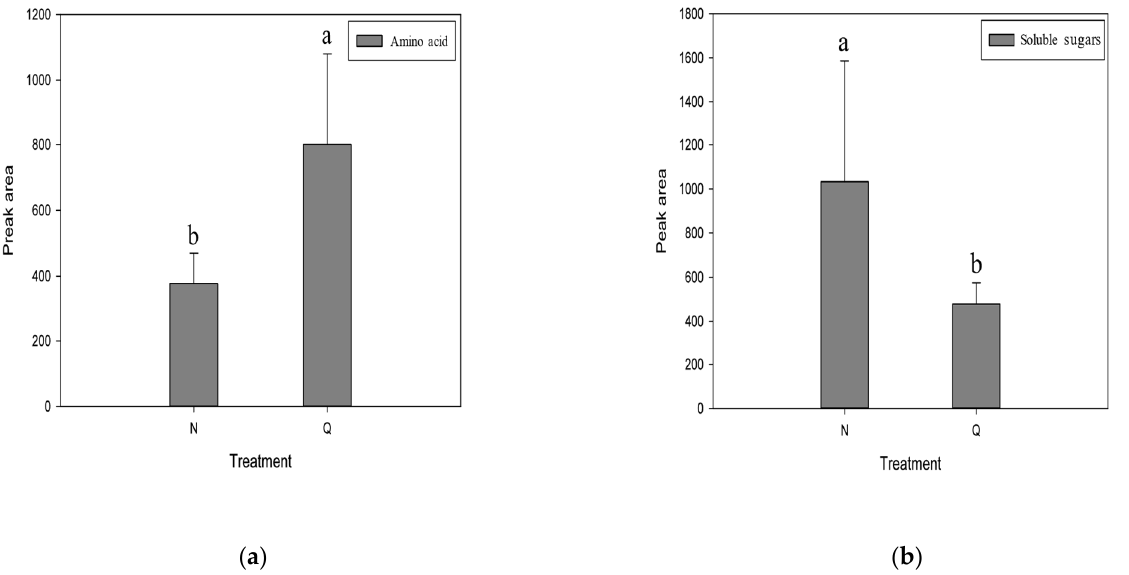
Figure 5. Changes in physiological indicators of R. chrysanthum under UV-B stress in control (N) and UV-B domestication treatments (Q). ( a ) Changes in amino acid content. ( b ) Changes in soluble sugars content.